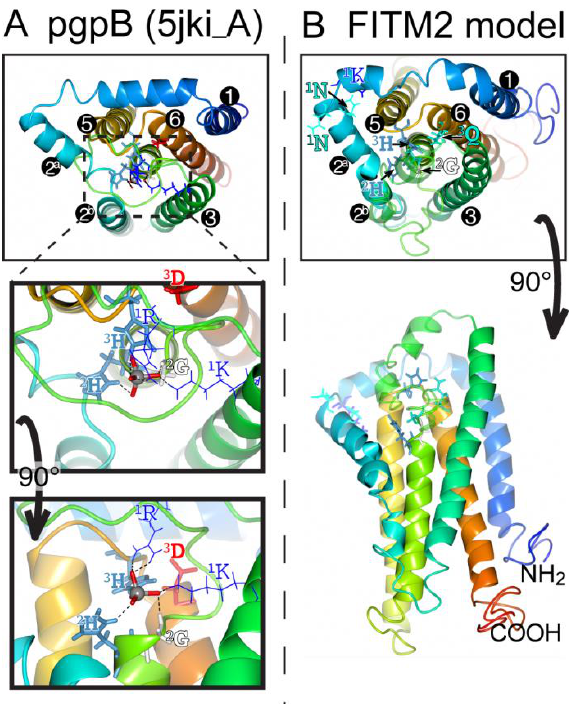
FIGURE 8: Structural model of FITM2 . (A) Lumenal aspect of bac- terial PgpB enzyme (accession 5jki, bottom panel), which is the highest scoring threading template for FITM2 identified by I- TASSER, numbering its 6 TMDs, except the central TMD 4, and with TMD2 split in 2 parts. Zoom in (middle panel) and rotation to side aspect (top panel) show the highlighted elements of the ac- tive site, including the tungsten ion (gray sphere) crystallised in place of the phosphate group in 5jki, and the side chains of co- ordinating conserved residues (coloured by residue type) in C1 (1K, 1R = thin bonds), C2 and C3 (2G, 2H, 3H, 3D = fat bonds) [60]. (B) Superimposed view of the modelled structure of human FITM2 with side-chains of the conserved residues in C2 and C3 as in A (bottom panel = lumenal aspect, top panel = side aspect), plus the hydrophilic residues (KxNxxN) conserved in loop 1/2 (thin bonds). Models were obtained from the I-TASSER server for 3D structure prediction with standard settings [61]. Several models with seven TMDs were rejected on the basis of topology studies of Yft2p and Scs3p showing six TMDs [13]. In all panels, colouring of the chain graduates from blue (N-terminus) to red